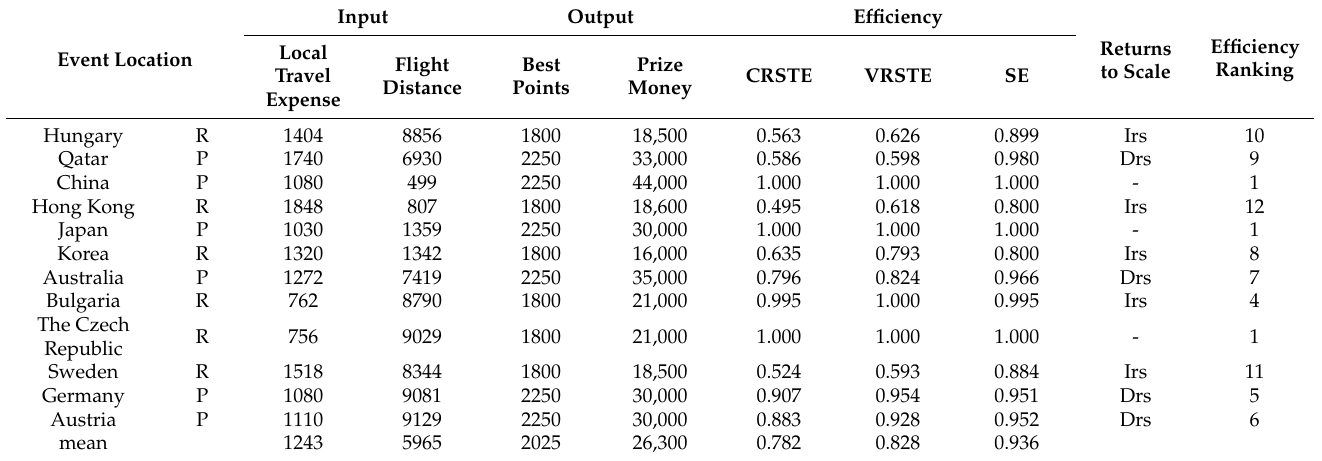
Table 4. Expenditure efficiency for the 2019 ITTF World